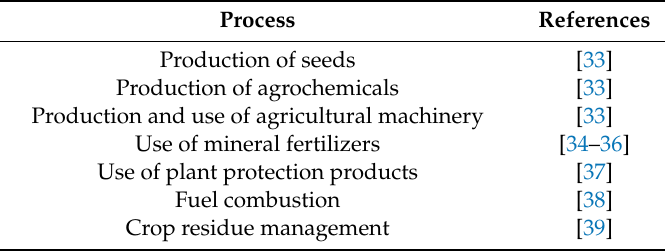
Table 4. Data sources for the life cycle inventory of the background processes and quantification of emissions from the foreground processes.